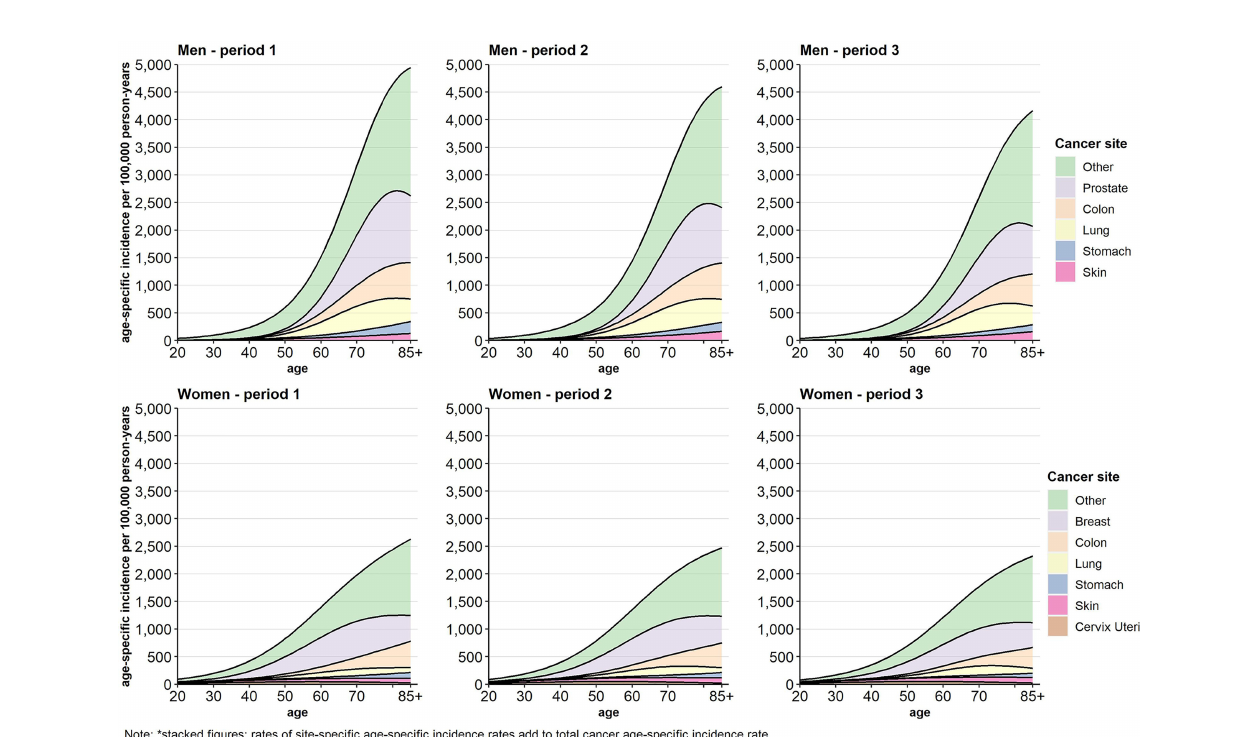
FIGURE 1 | Age-speci fi c incidence (stacked fi gure)* per 100,000 person-years by cancer site, sex, and